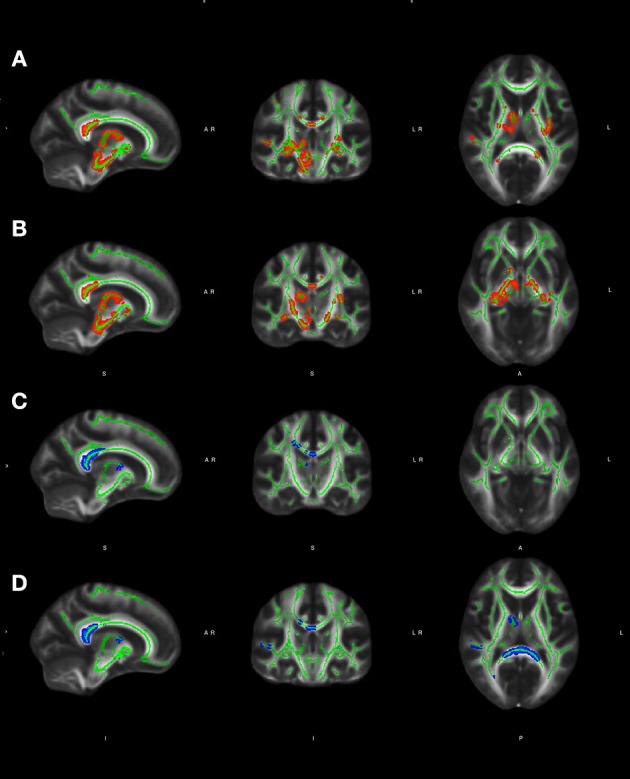
(A, B) Significant group effect adjusted for age and gender (thresholded at p, p ≤ 0.001) for voxel-wise statistics comparisons (late vs. early onset BD) with whole-brain FA in white matter areas of both hemispheres shown on skeletonised FA maps, using the standard MNI152 1 x 1 x 1 mm brain template; (C, D) Significant group effect adjusted for age and gender (thresholded at p < 0.001) for voxel-wise statistics comparisons (LOD vs. controls) with whole-brain FA in white matter areas of both hemispheres shown on skeletonised FA maps, using the standard MNI152 1 × 1 × 1 mm brain template. Color-code: red-yellow: early onset BD > LOD, blue-lightblue: controls > LOD. The FA skeleton is marked in green. All images are shown in radiological convention (left is right). Coordinates: (A) e (D): X: 10, Y: −8, Z:10; (B) e (C): X: 12, Y:−16, Z:4.